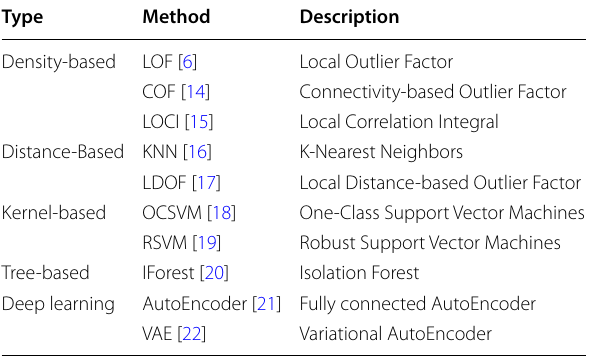
Table 1 A classification of classic unsupervised performance anomaly detection